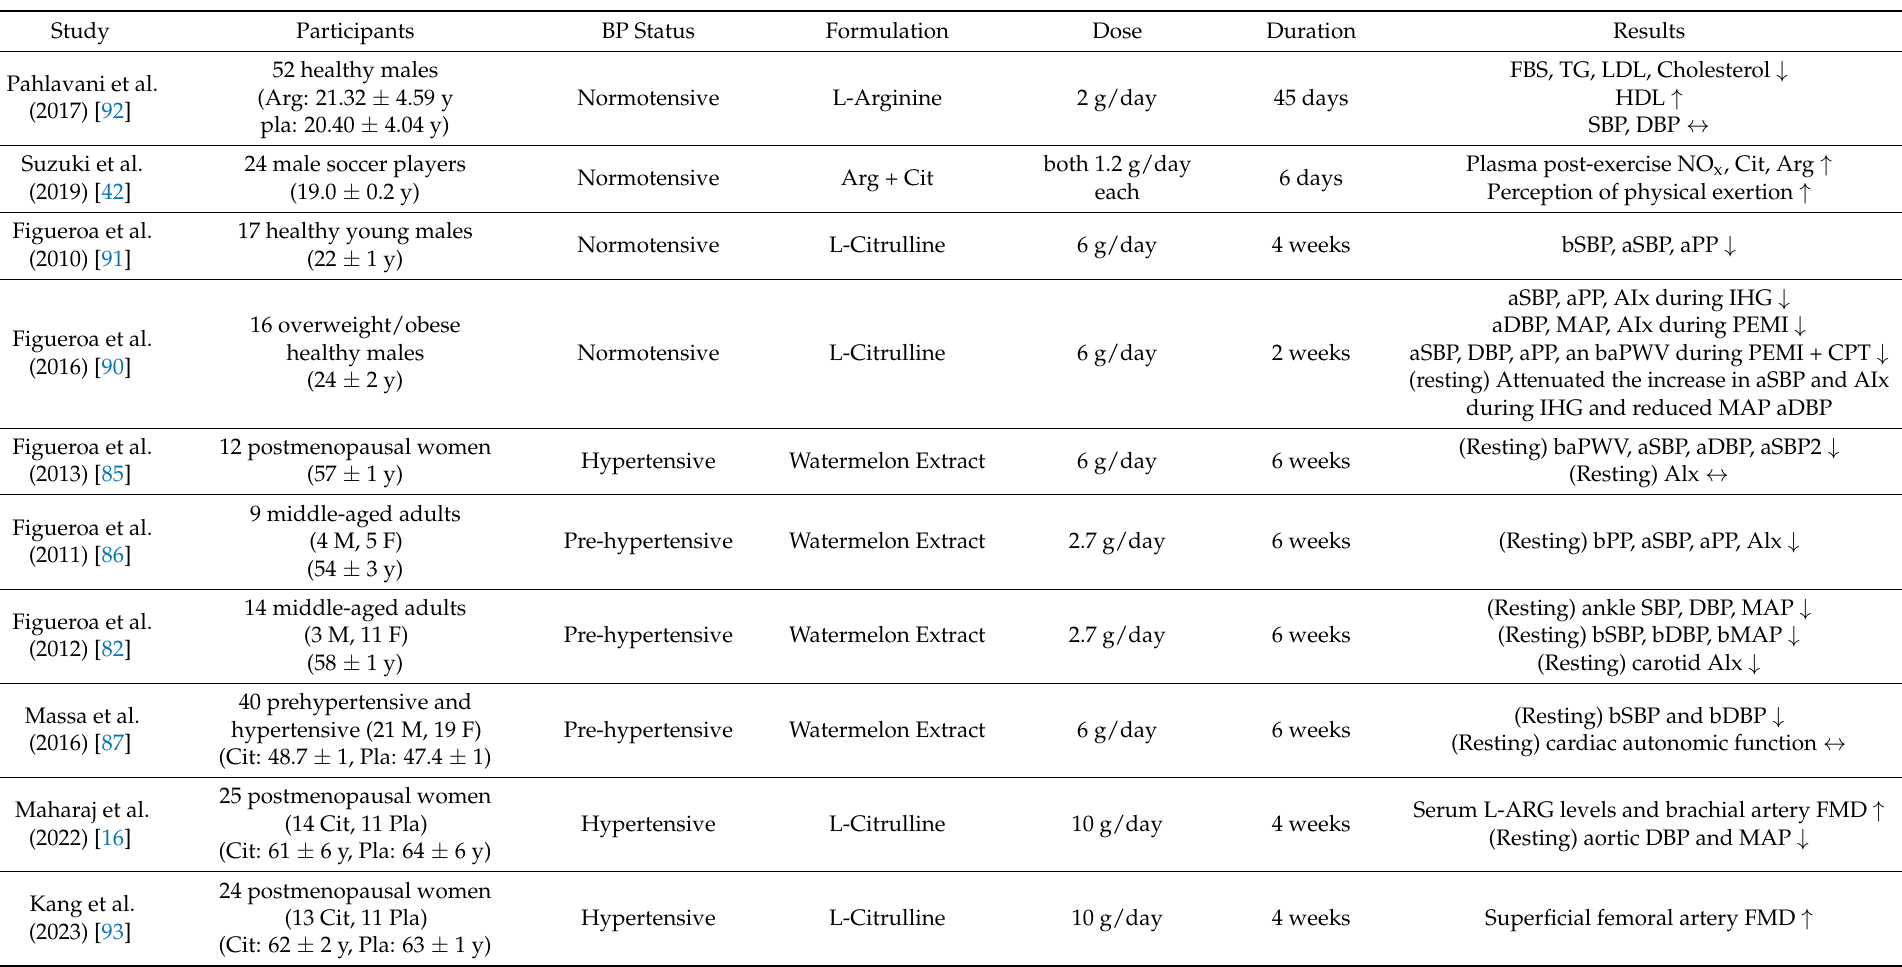
Table 1. The effects of Arg and Cit supplementation on cardiovascular